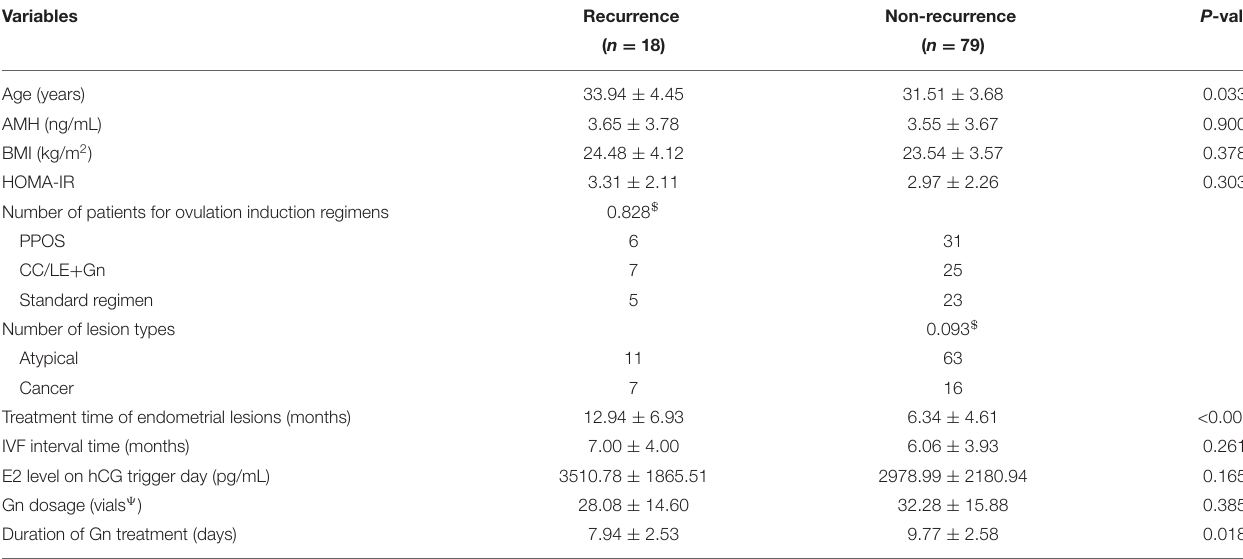
TABLE 3 | Univariate analysis of risk factors with the recurrence of endometrial diseases.